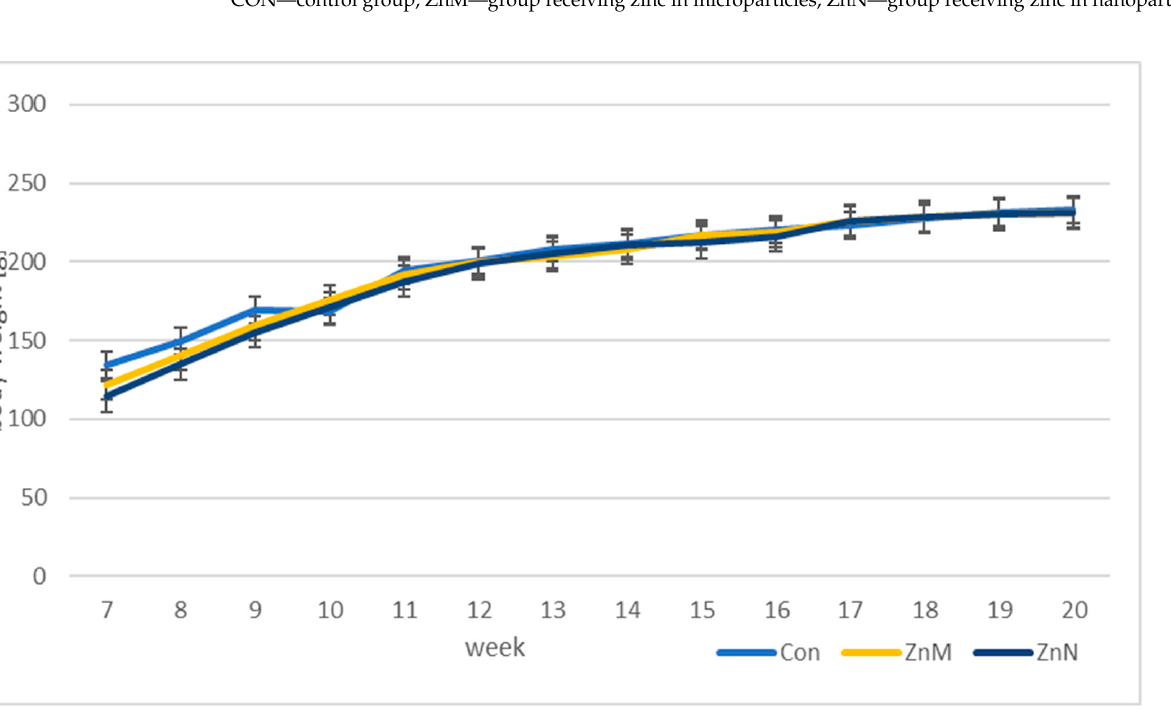
Table 2. Characteristic of experimental groups.